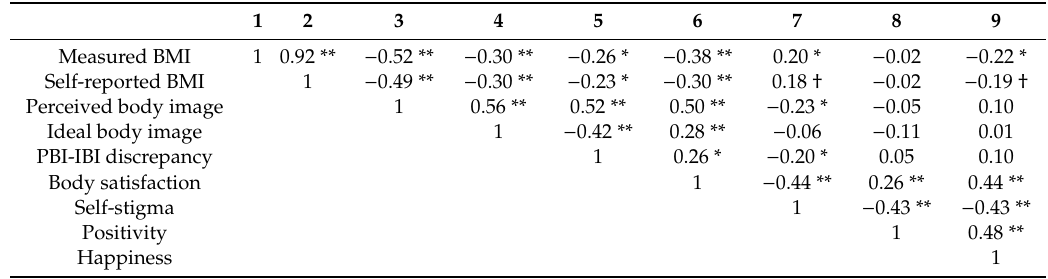
Table 2. Bivariate Pearson’s correlations among the study variables.